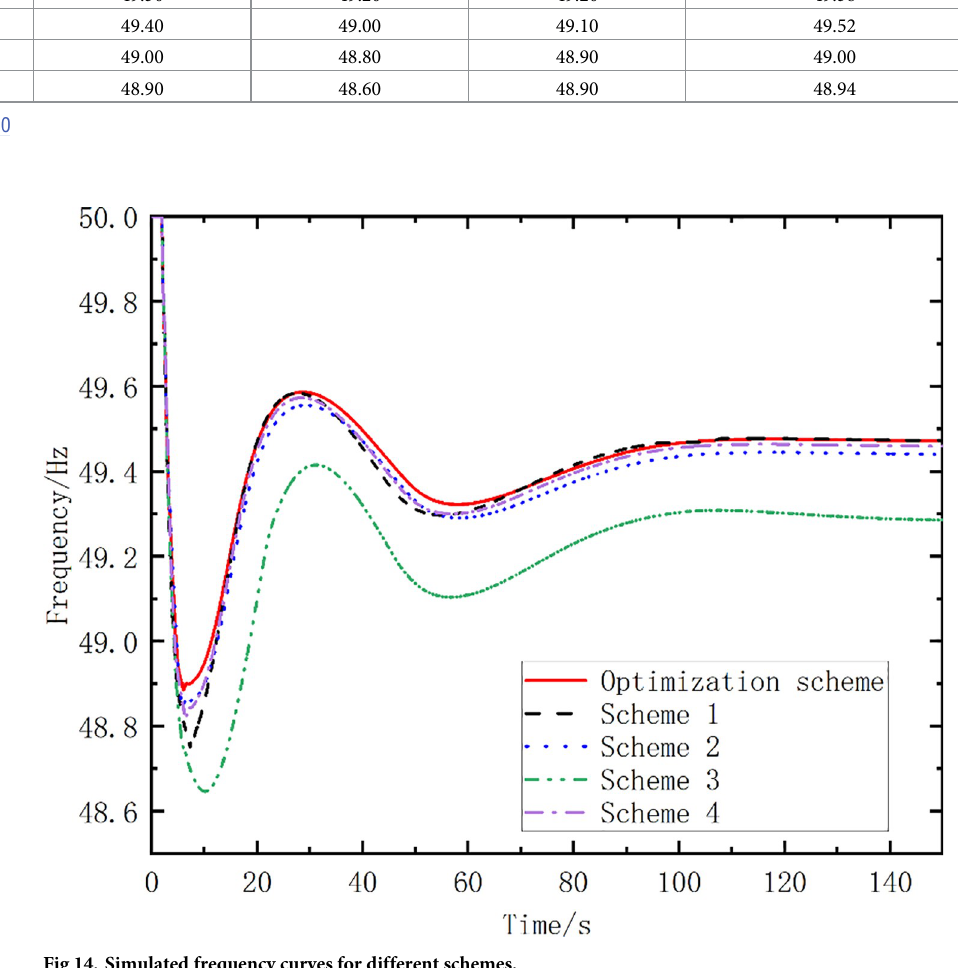
Fig 14. Simulated frequency curves for different